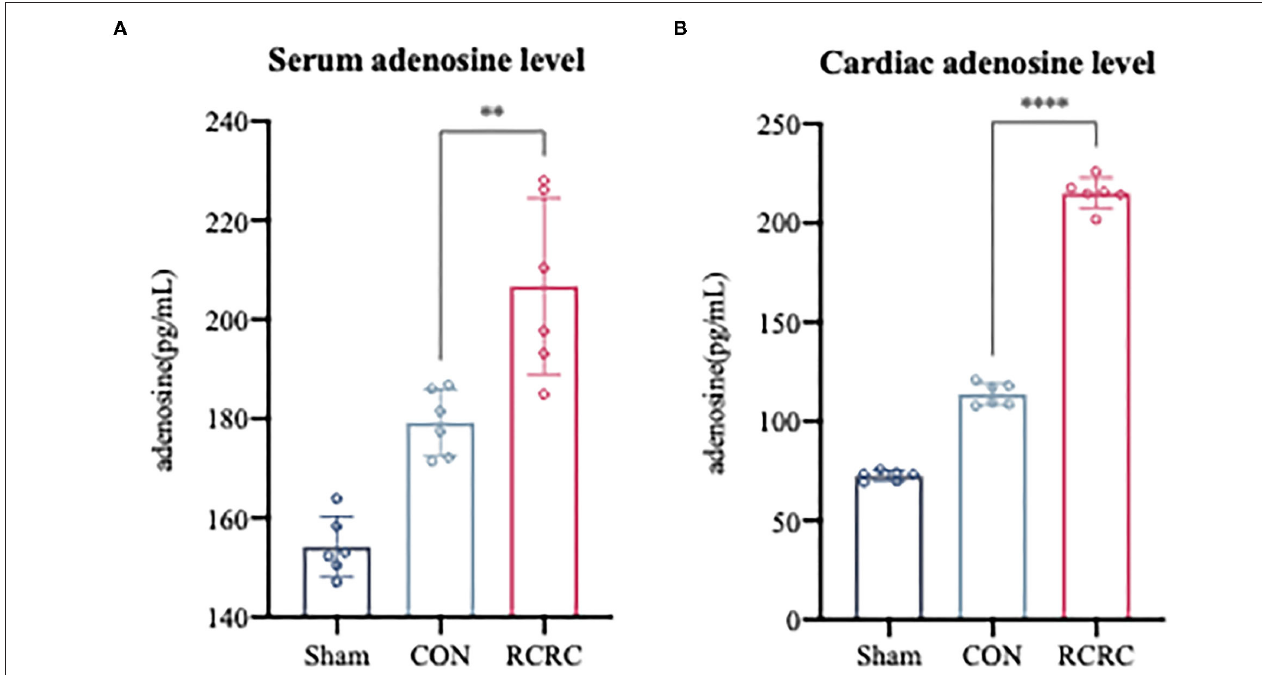
FIGURE 3 | Remote conditioning by rhythmic compression increases serum and myocardial adenosine concentrations in a rat model of AMI. (A) Serum adenosine concentration after 3 days of remote conditioning, N = 6. (B) Adenosine concentration in infarct zone after 3 days of remote conditioning. All values represent as